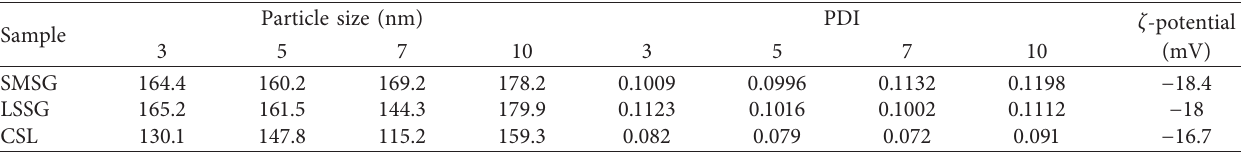
Table 1: Particle size, polydispersity index (PDI), and zeta potential of W/O/W double emulsions stabilized by different wall materials at four time cycles.